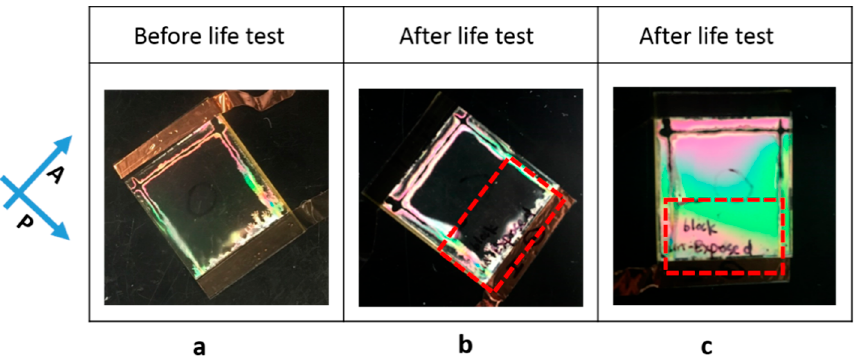
Figure 10. Macroscopic observation of the cell before photo-bleaching ( a ) and after photo-bleaching ( b , c ). The original LC alignment was parallel to one polarizer ( b ) or 45° to one polarizer ( c ). Half of the cell (highlighted in the dashed line box of b , c ) was masked during the exposure. Therefore, a uniform dark state across the cell indicates stable alignment.